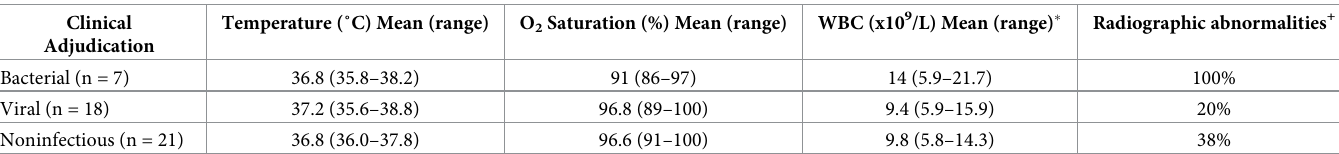
compared to the bacterial (54 years) and noninfectious groups (58 years).